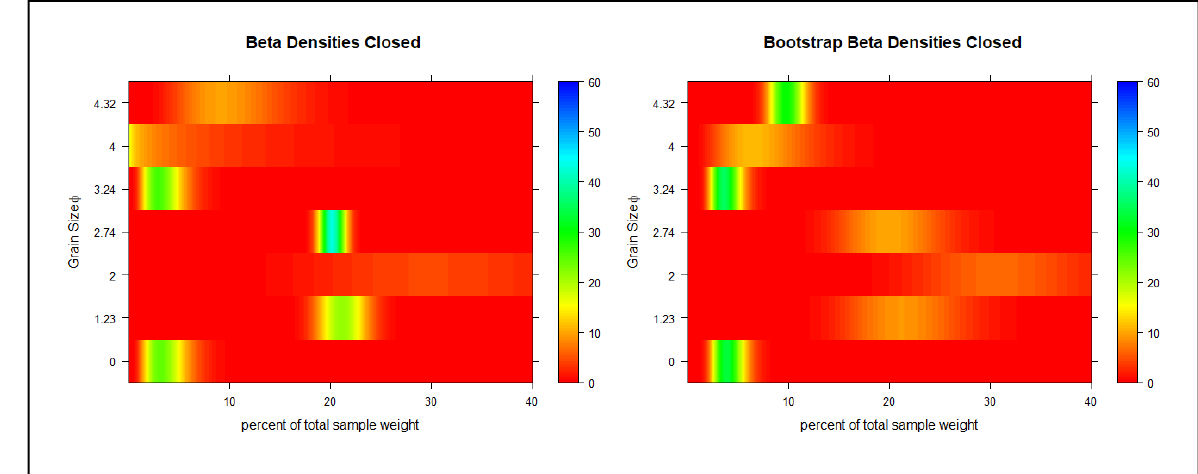
Figure 6. Closed test—heat maps of original samples and bootstrap samples.